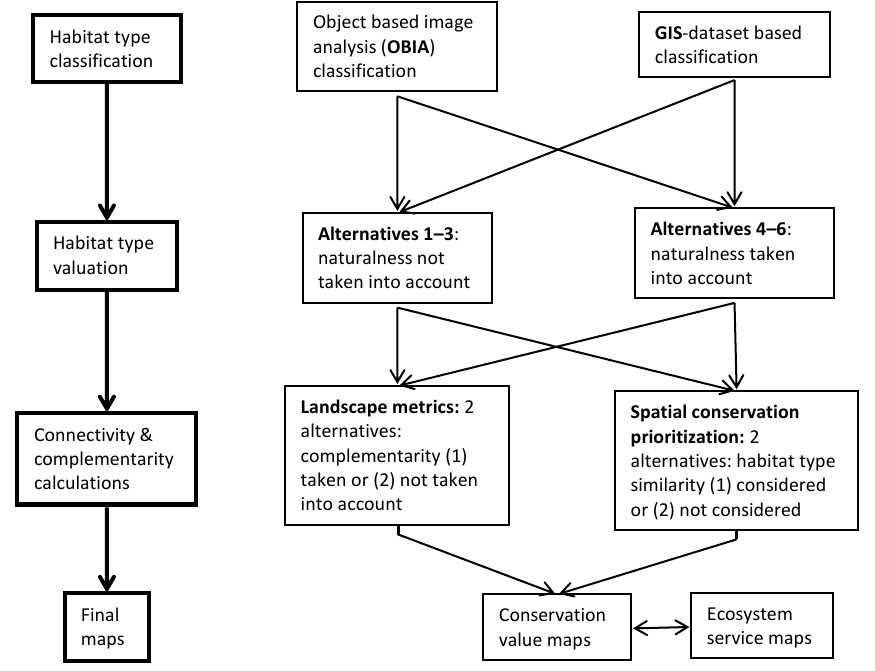
Figure 2: A flow chart of the used methods. Different stages are represented on the left. On the right, different alternatives in each stage are elaborated. First, we classified habitat types using two different alternatives. Second, value maps to maps of ecosystem services